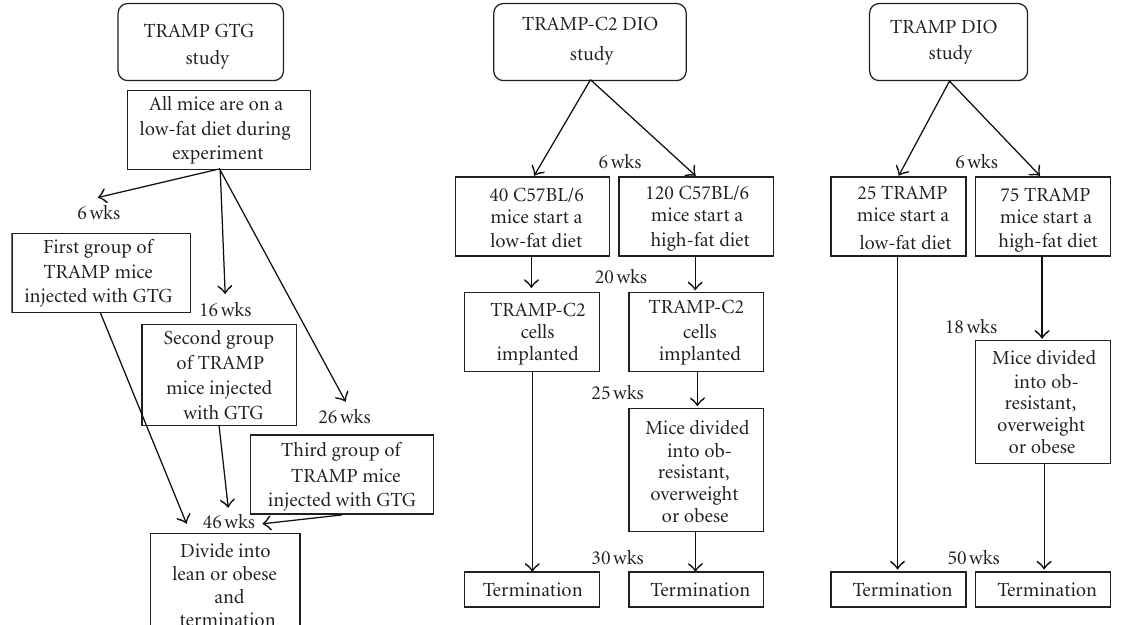
Figure 1: Flow chart of the three di ff erent studies whose results are discussed in this paper. Boxes at top show name of study. Arrows show movement of groups over time. Wks is weeks of age. Termination was either the wks stated or when the mice reached experimental endpoints related to tumor size and